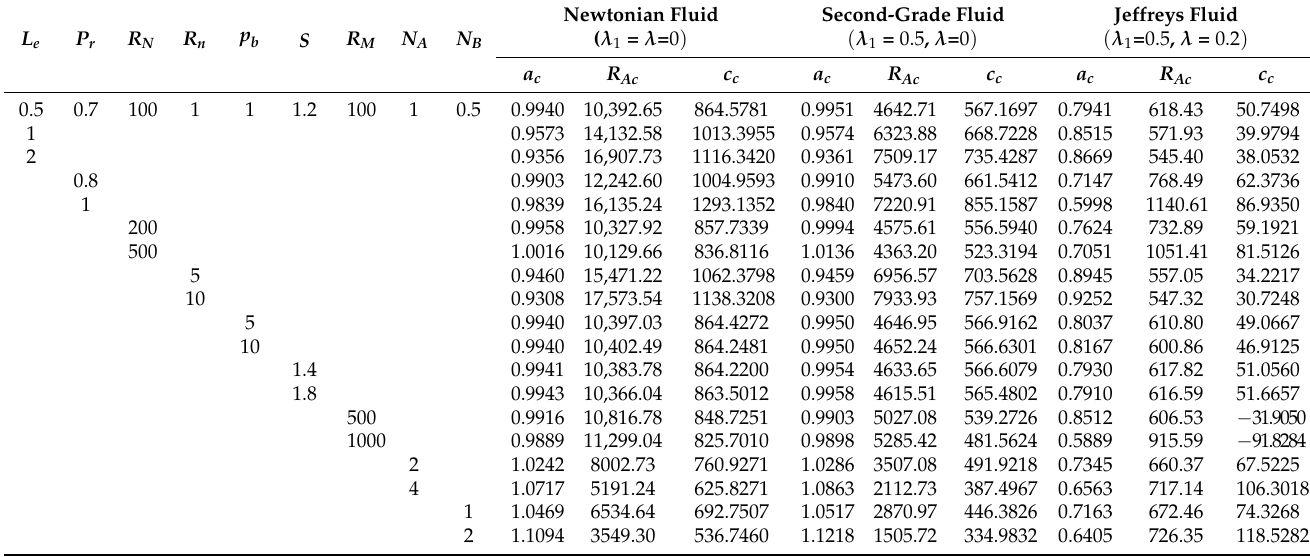
Table 2. Comparison between the critical stability parameters of the Newtonian, second-grade and Jeffreys fluids for various governing